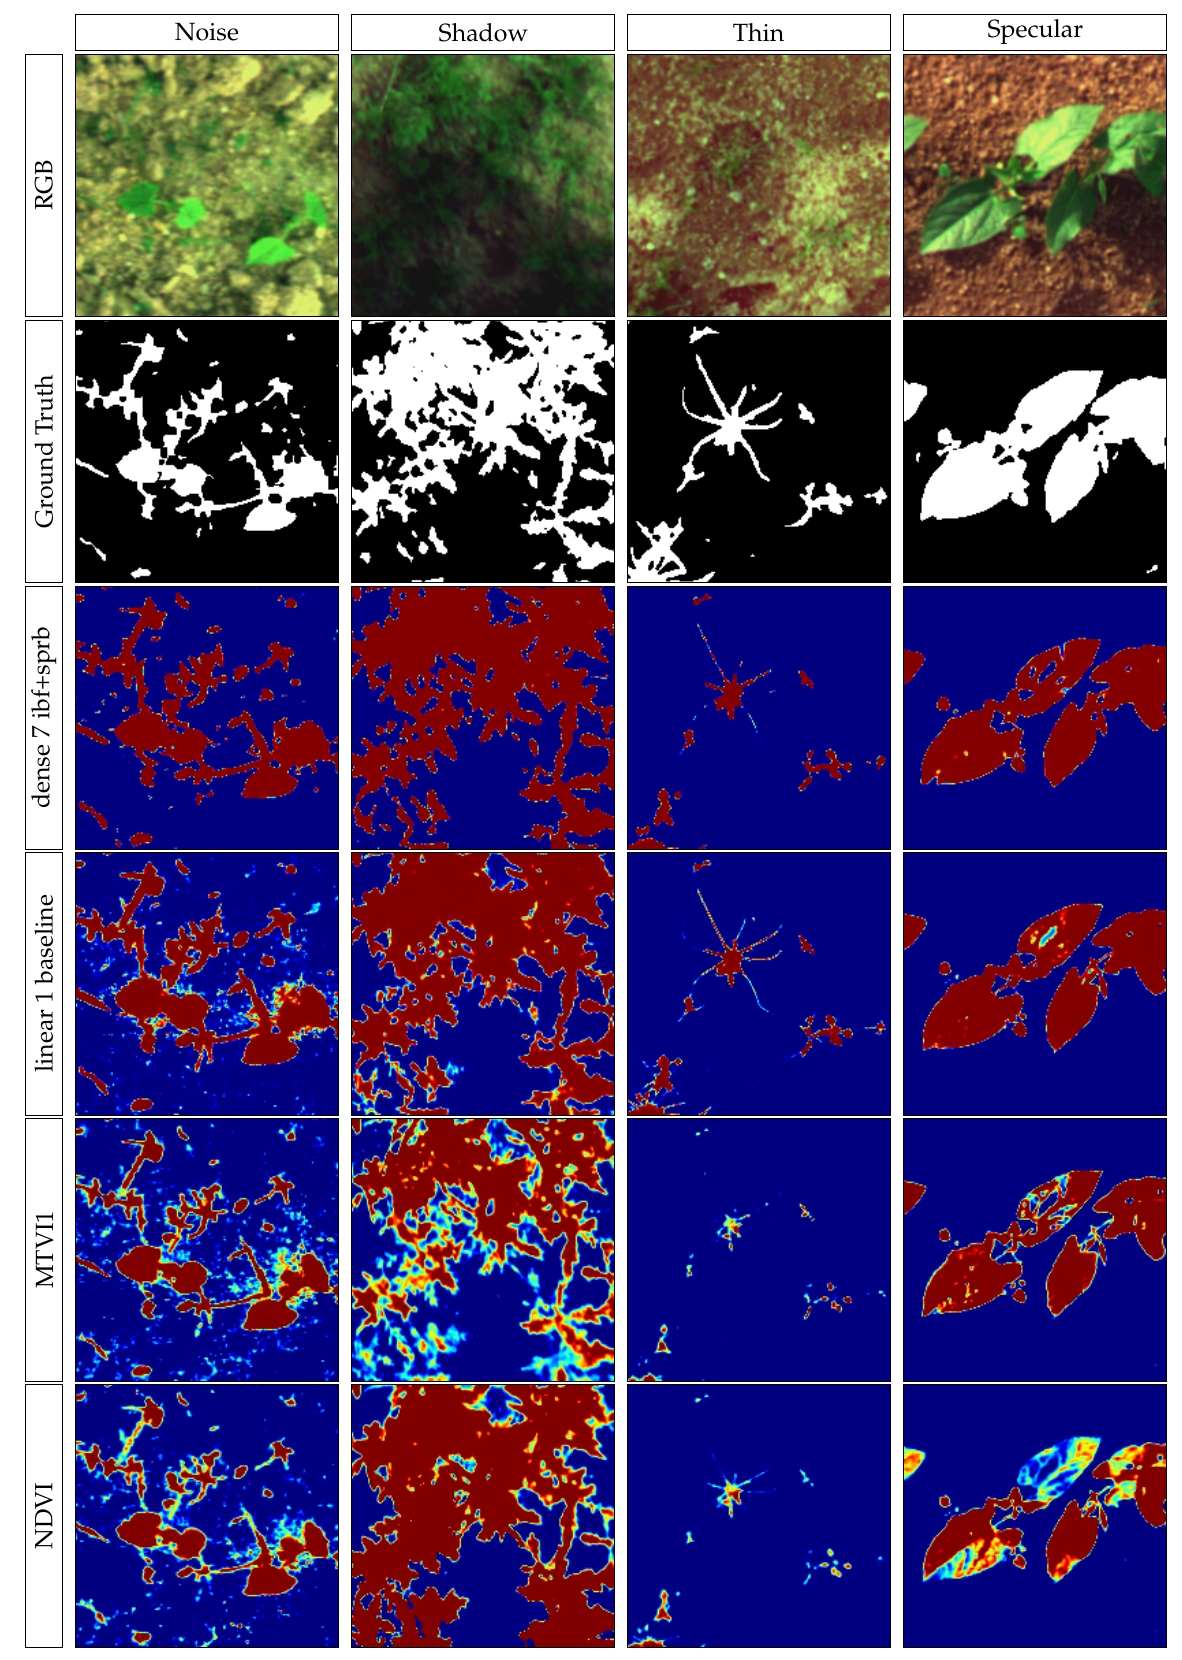
Figure A1. Visual comparison between some relevant models. NDVI (63.98 mIoU), MTVI1 (73.71 mIoU), linear 1 baseline (78.58 mIoU), dense 7 ibf-sprb (82.19 mIoU). Blue indicates sure soil, red indicates sure vegetation, and the other colors indicate